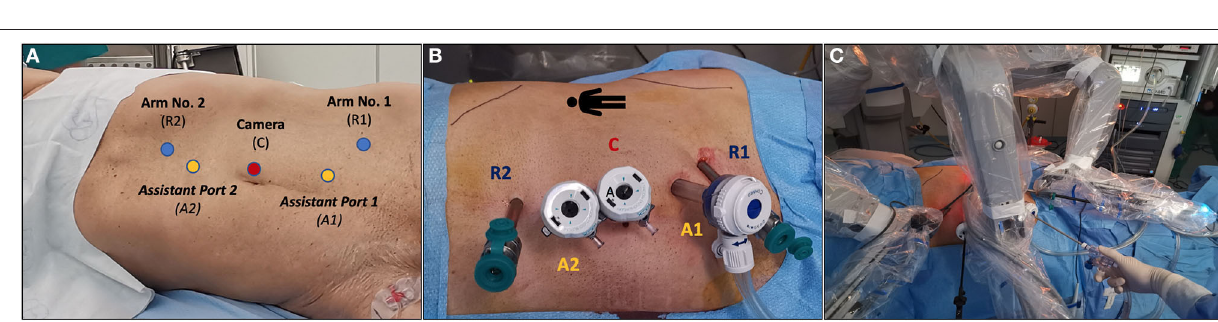
FIGURE 2 | Vascular anatomy of our case with focus on the main renal arteries feeding the left-sided portion of the horseshoe kidney (HSK) and on the clamping strategy adopted by the surgeon. A selective delayed clamping strategy was performed for resection of the larger renal mass (A,B) while a clampless strategy was chosen for resection of the smaller renal mass. A linked video clip is available scanning the QR code on the right side of the image. For Apple users: open the Camera app from your devices. Hold your device so that the QR code appears in the Camera app’s viewfinder. Your device recognizes the QR code and shows a notification. Tap the notification to open the link associated with the QR code. For Android users: download a QR code scanner app and follow the above instructions.